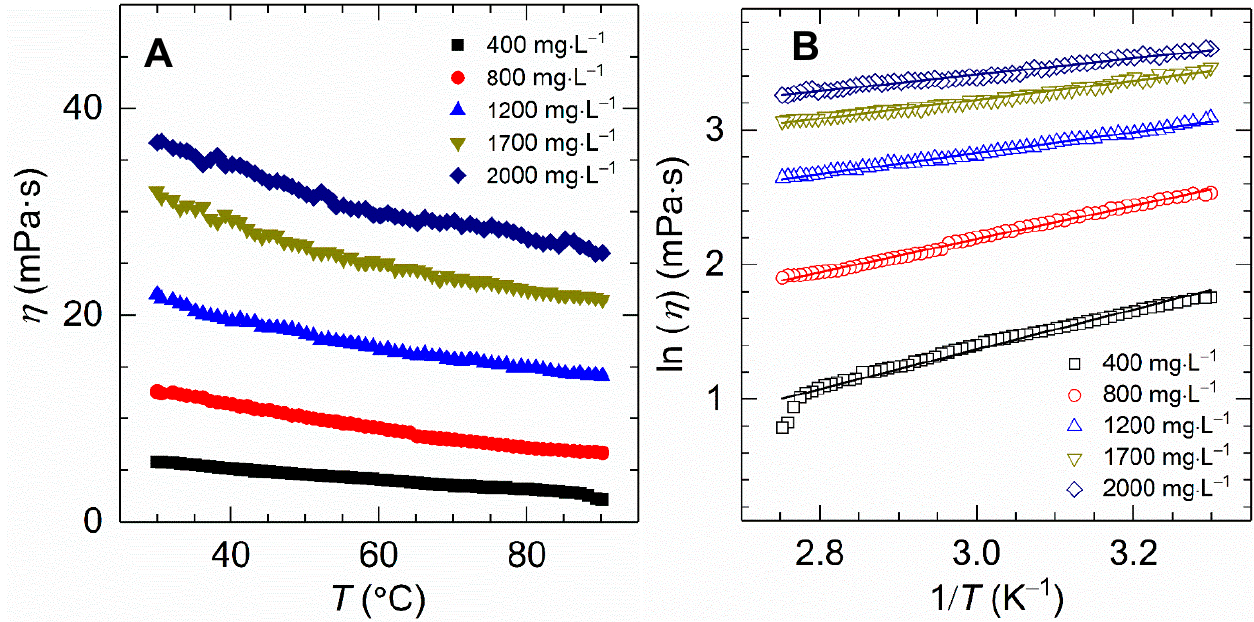
Figure 6. ( A ) Effect of temperature on apparent viscosity for HVFR solutions with different concentrations; ( B ) Logarithmic plots of viscosity against the reciprocal of temperature for HVFR.